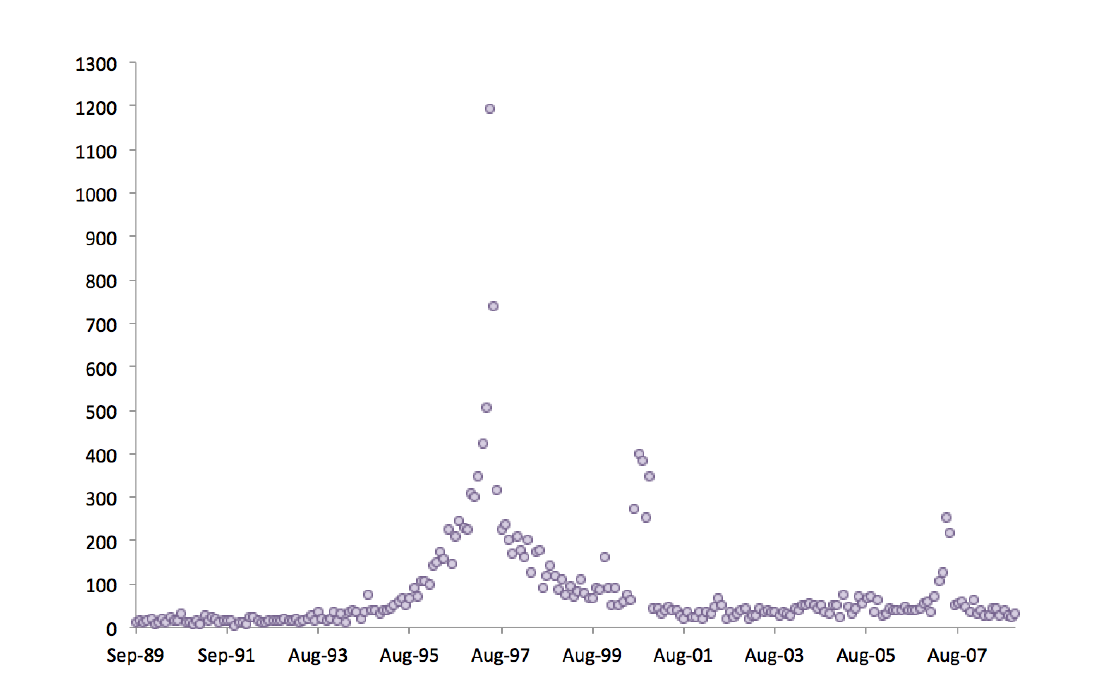
Figure 3: Monthly Count of Articles Mentioning “Handover” in SCMP